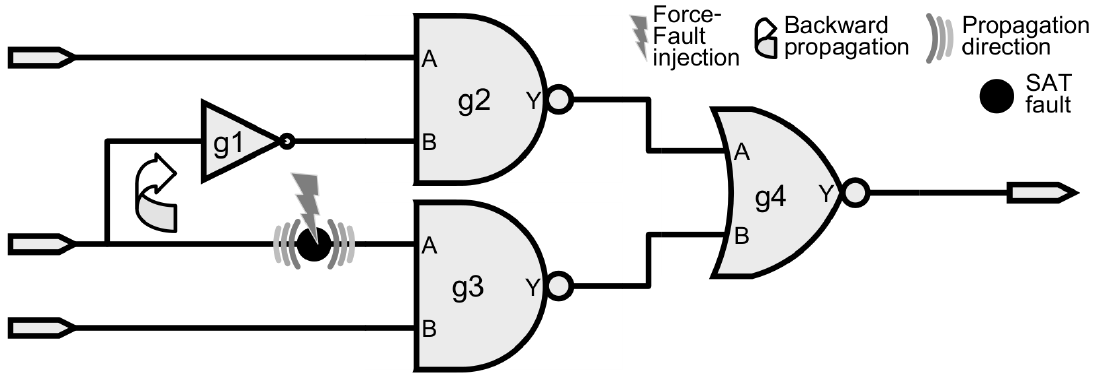
Figure 2. Backward propagation problem associated with the force